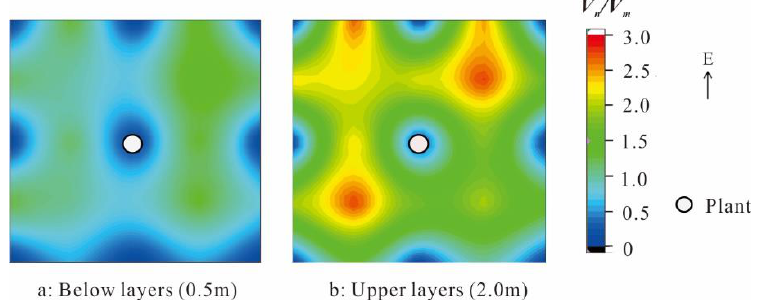
Figure 6. Airflow distribution of below layers ( a ) and upper layers ( b ) of the H. rhamnoides community.